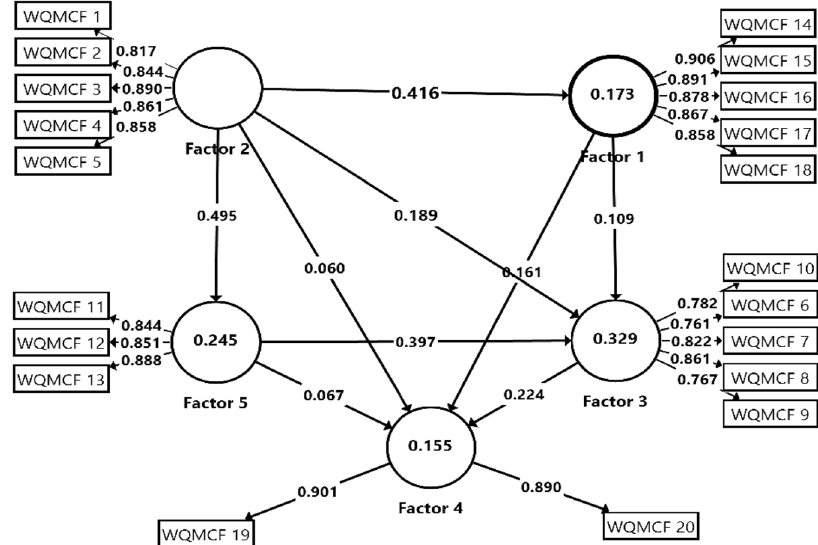
Fig. 1 Conceptual model of the fi ve WQMCF factors. Con fi rmatory factor analysis and structural model of the diagnostic scale for Muslim couples and